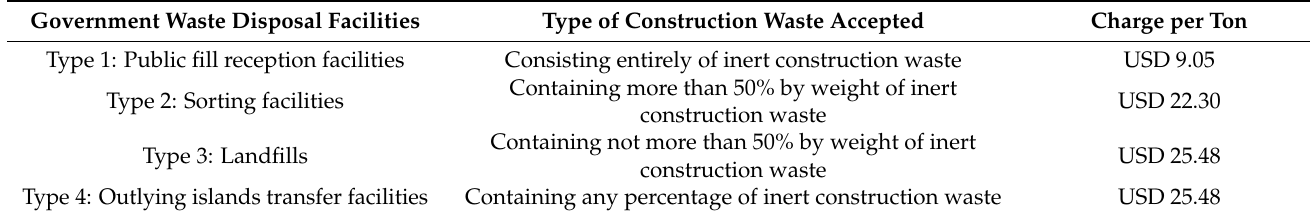
Table 2. The charge level of government waste disposal facilities in Hong